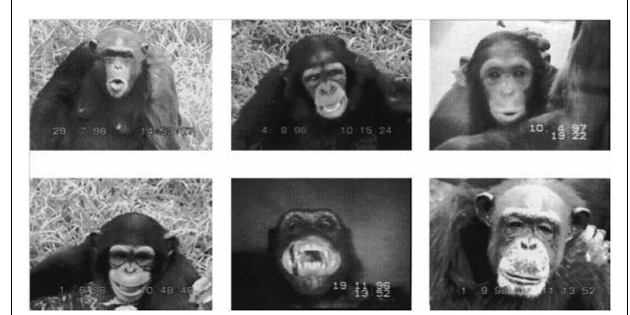
FIGURE 3 | Examples of chimpanzee facial expressions .Top row from left to right: pant-hooting, play face, silent pout. Bottom row from left to right: silent bared-teeth display, staring bared-teeth scream face, neutral face (Reprinted from Fernández-Carriba et al., 2002a, Copyright with permission from